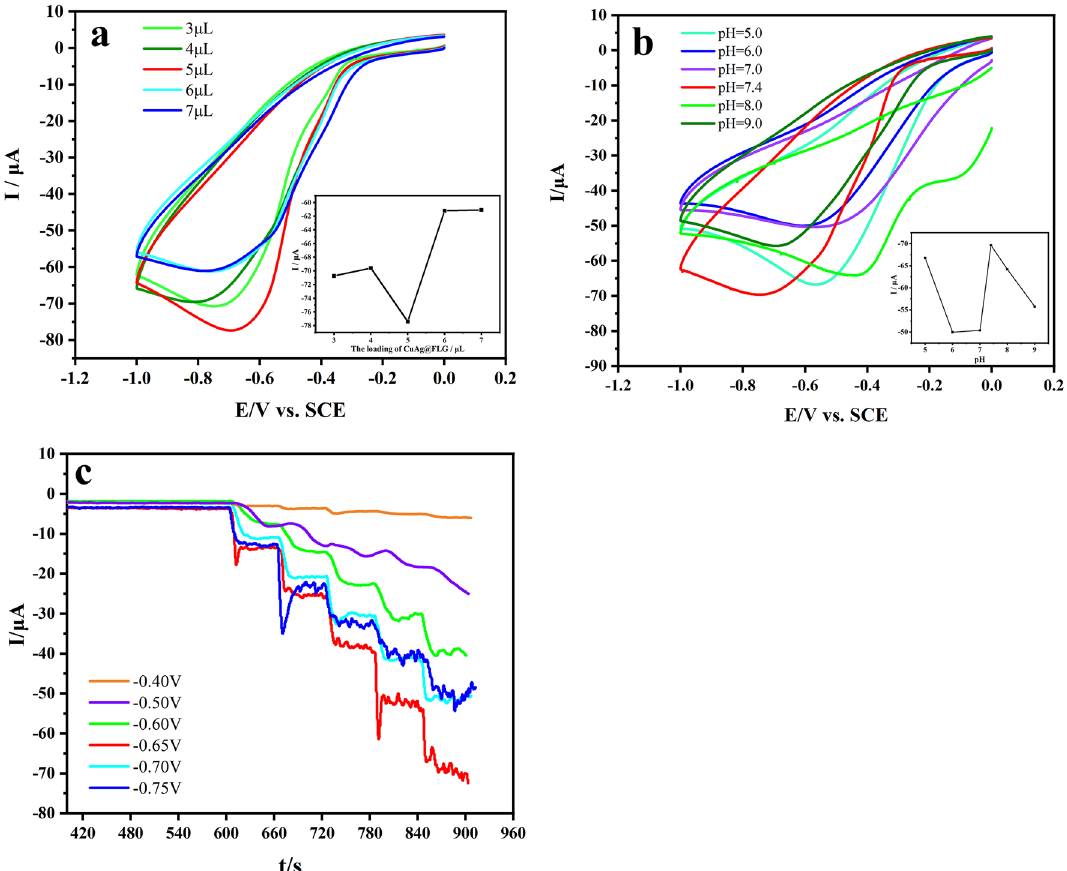
Figure 6. CVs at a scan rate of 0.05 V s −1 of Cu x O/Ag@FLG/GCE ( a ) with different volume of Cu x O/Ag@FLG in 0.01 M PBS (pH 7.4) containing 4.0 mM H 2 O 2 ; ( b )in PBS with different pH include 5.0, 6.0, 7.0, 7.4, 8.0, 9.0